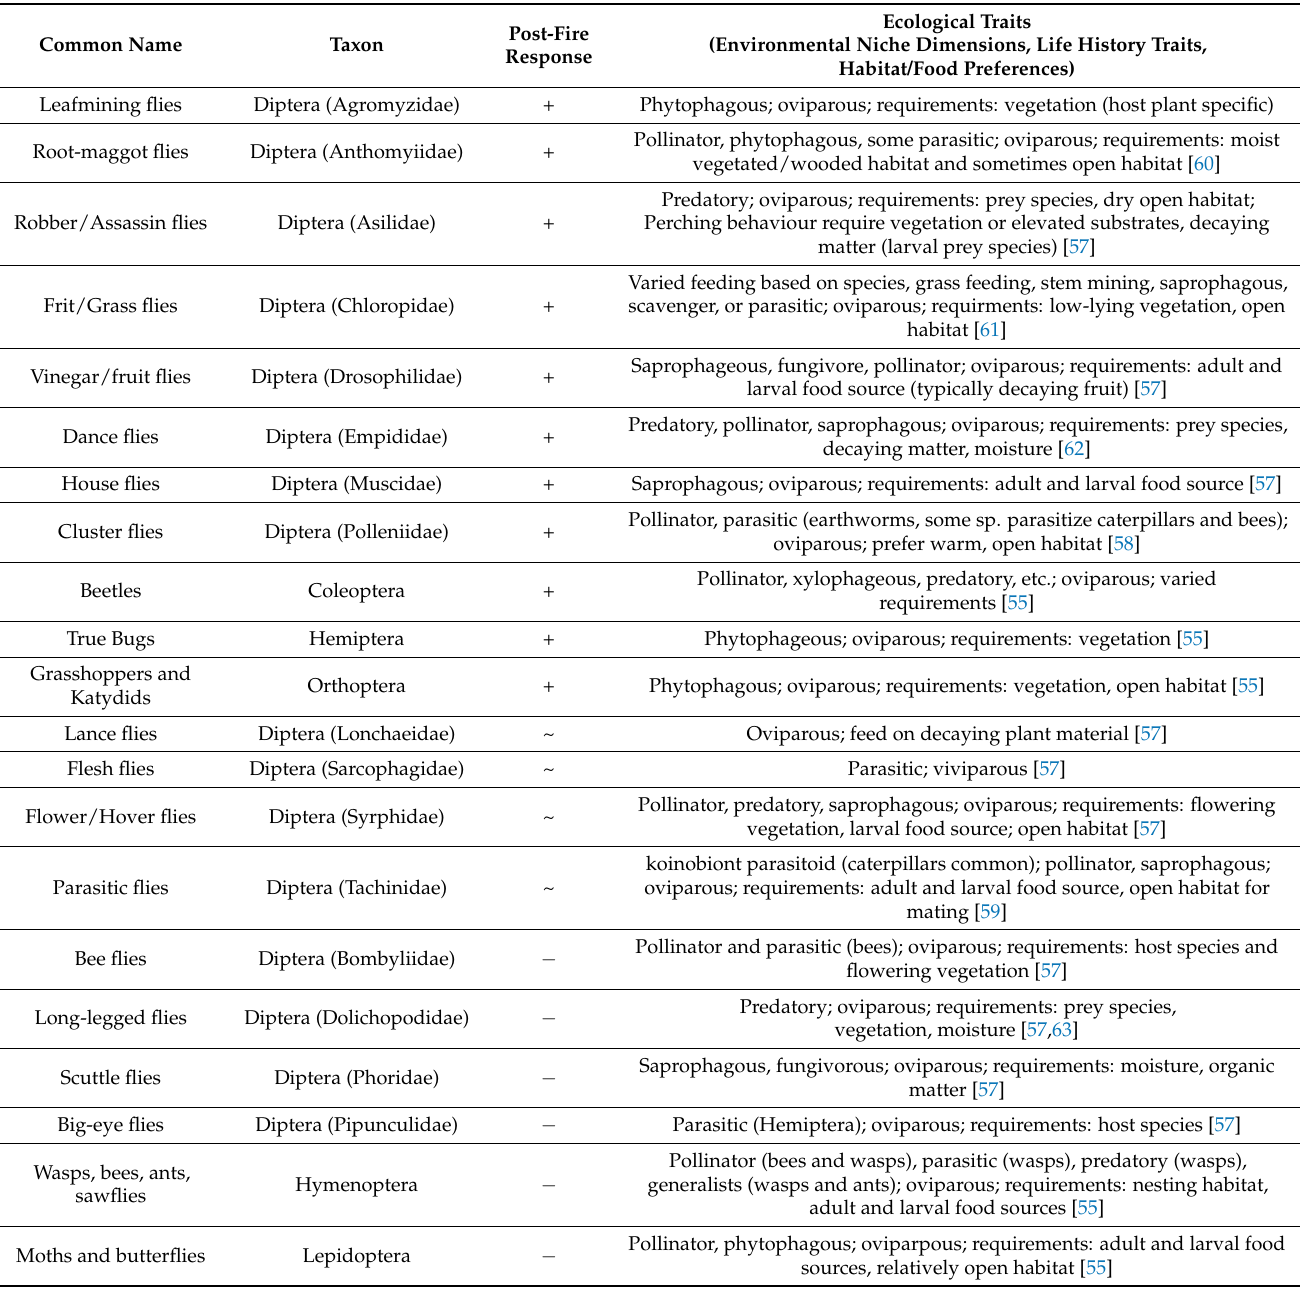
Table 2. Insect taxa ecological traits and response trends from this study, with “+” indicating a positive response, “~” indicating a neutral response, and “ − ” indicating a negative